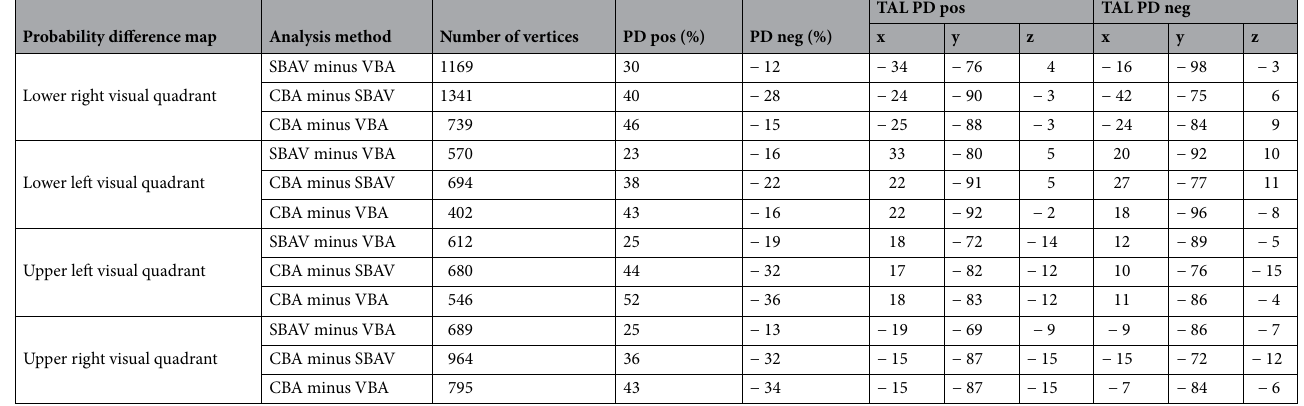
Table 6. Extent of probability difference maps (PDMs) including positive and negative foci. For each visual quadrant and comparison between analysis methods (SBAV minus VBA, CBA minus SBAV, CBA minus VBA), we counted the number of vertices in the corresponding PDMs exceeding the threshold of plus 5% or minus 5% difference in probability of activation overlap. Overall, the extent of PDMs was greatest for the CBA minus VBA comparison, i.e., the combined effect of surface-based analysis and macroanatomical alignment. We also extracted Talairach (TAL) coordinates of the positive and negative foci for each quadrant and each data set. PD pos positive value of probability difference, PD neg negative value of probability